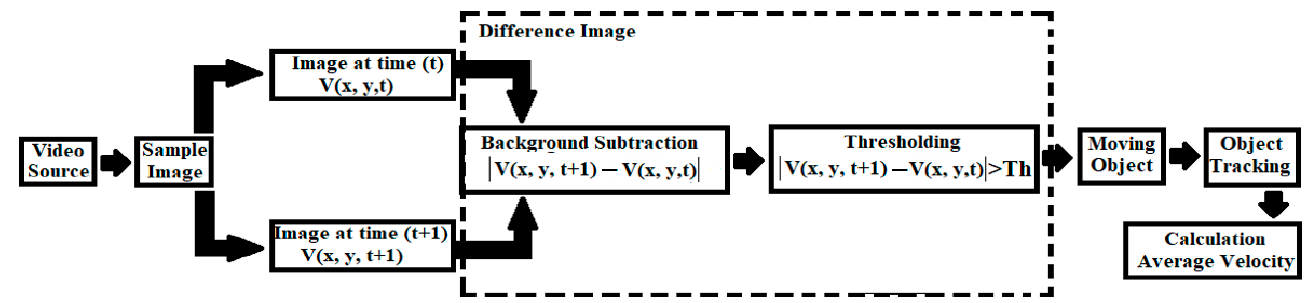
Figure 8. Flowchart for object detection and tracking using the background subtraction method.